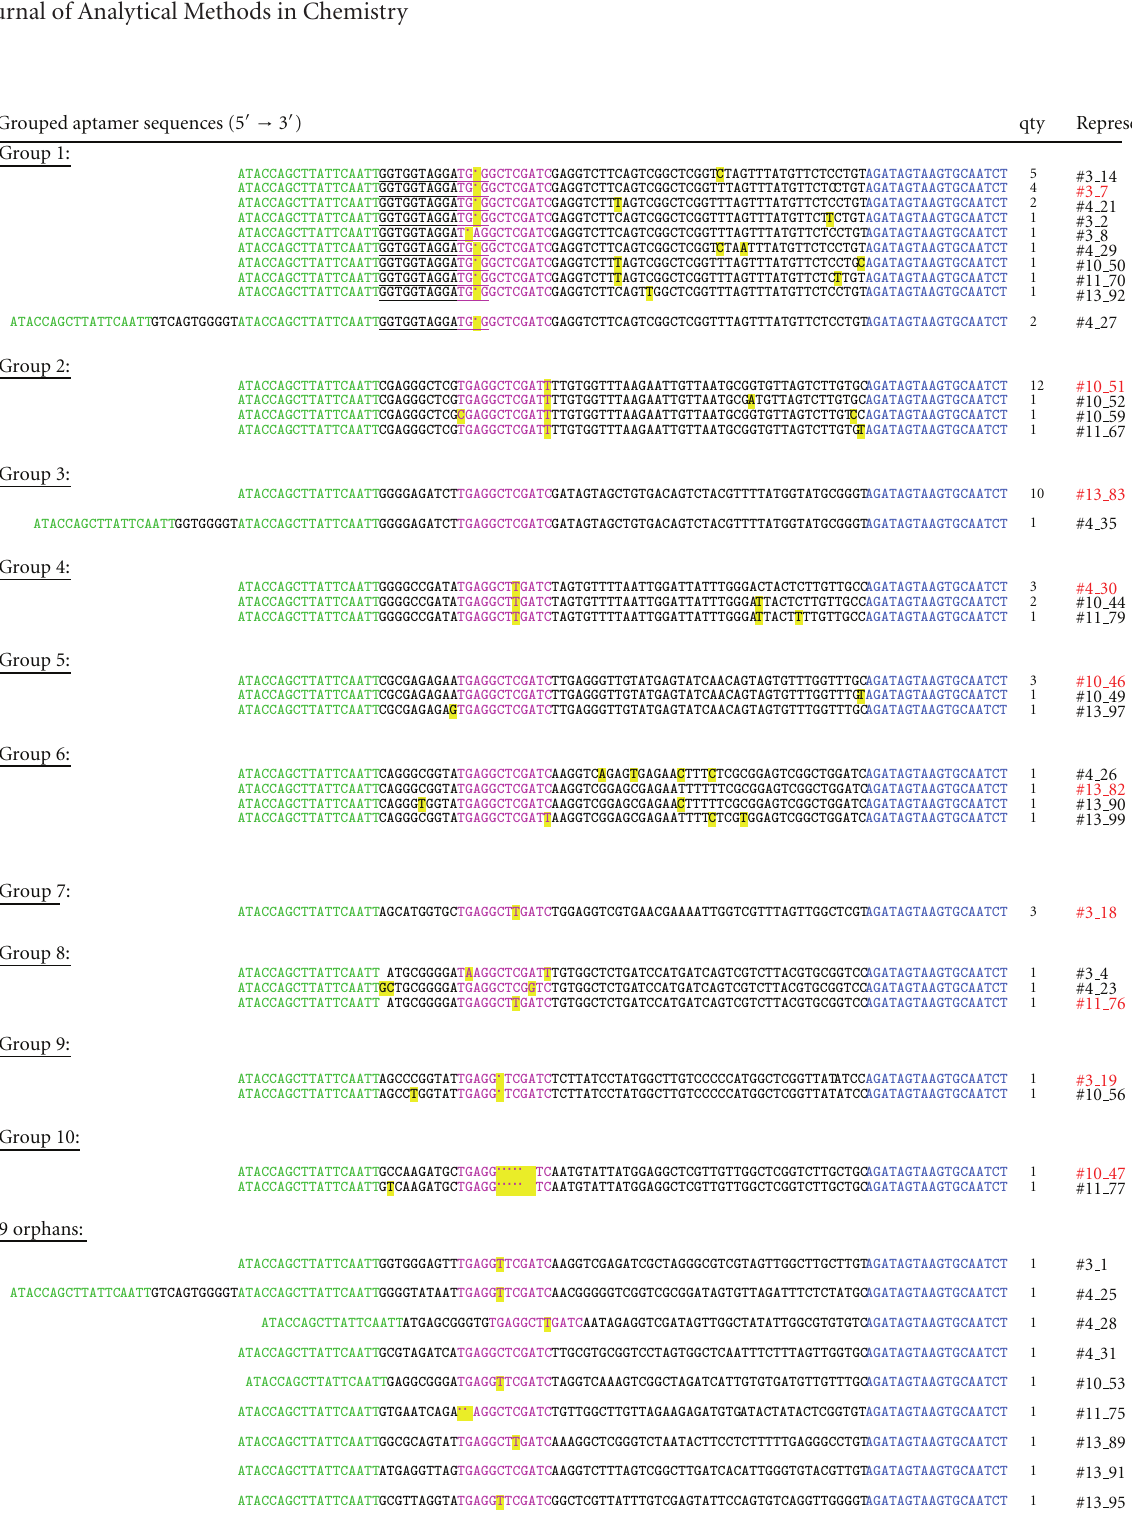
Figure 4: Groups and orphans of oligonucleotides (5 (cid:4) → 3 (cid:4) ) obtained after cloning and sequencing of the single stranded DNA that was selected by the target mixture (kanamycin A disulfate salt dihydrate, sulfacarbamide, sulfamethoxazole, and sotalol hydrochloride, each 1mM in selection bu ff er) during 13 Capture-SELEX rounds. The representative of each group is printed in red. Each group could be divided into subgroups of totally identical sequences. The number of sequences in each subgroup is given (qty), and the representative is printed in black. Green: binding site for primer AP60 (18mer), magenta: docking sequence, originally: TGAGGCTCGATC, blue: binding site for primer AP20 (18mer), yellow marking: sites of base exchange or deletion, and underlined: possible G-quadruplex